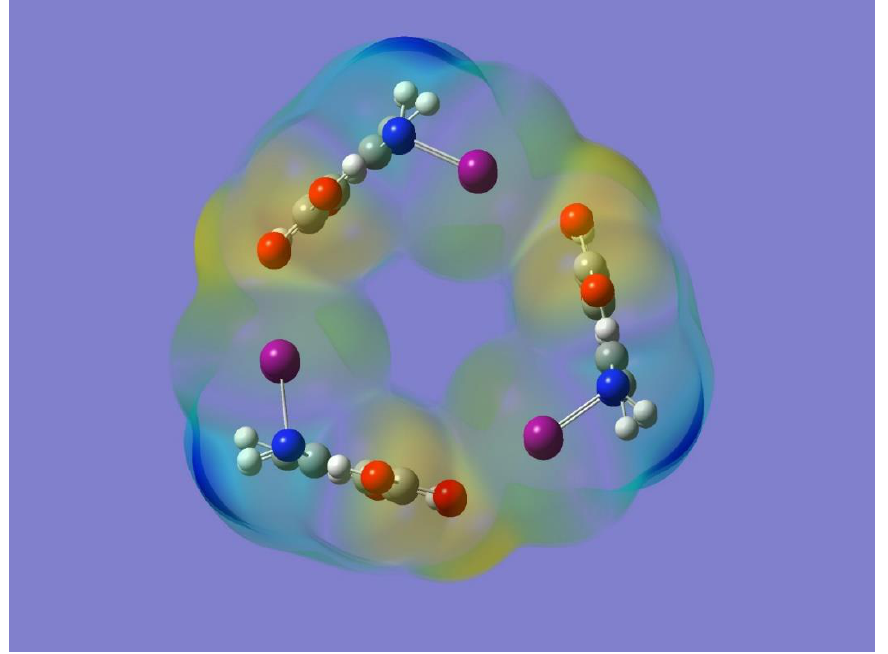
Figure 7. Electrostatic potential on the 0.001-au molecular surface of the optimized trimer system. Yellow-red represents the most negative electrostatic potential and blue the most positive.